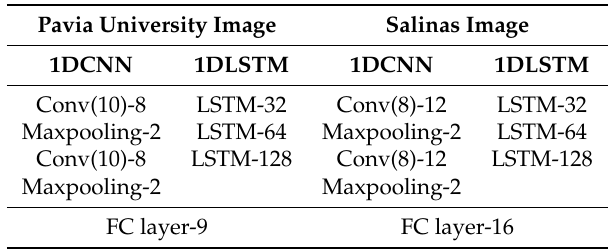
Table 2. Parameter settings for 1D-CNN and 1D-LSTM, where the convolutional layer is represented as “Conv(number of kernels)-(kernel size)”, maxpooling layer is performed as “Maxpooling-(kernel size)”, and LSTM layer is denoted as “LSTM-(kernel